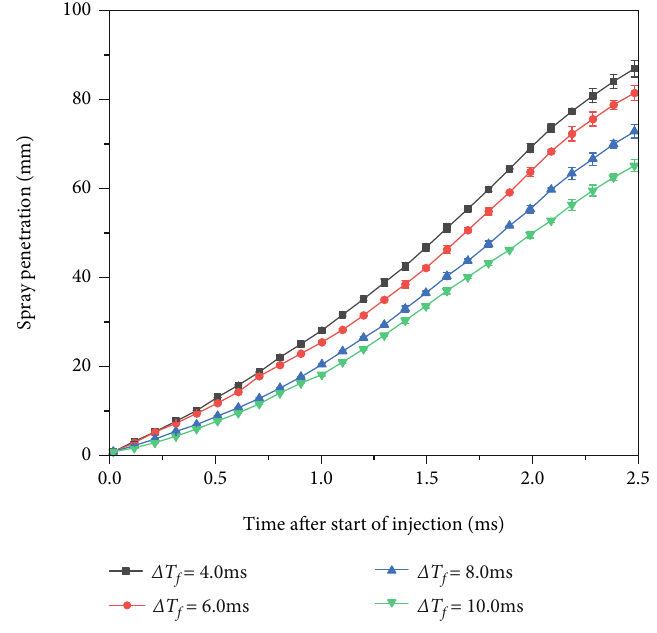
= 0 : 8 MPa , T = 298 K ). f f